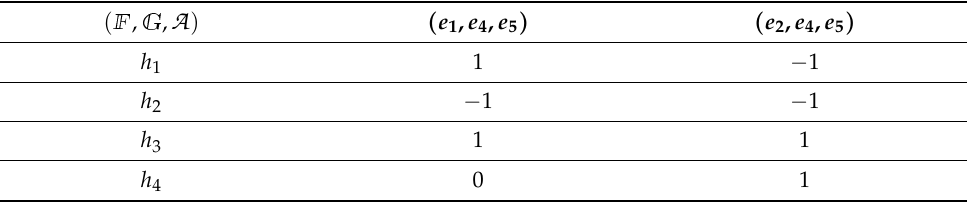
Table 2. A single table is used to represent ( F , G , A ) in a tabular